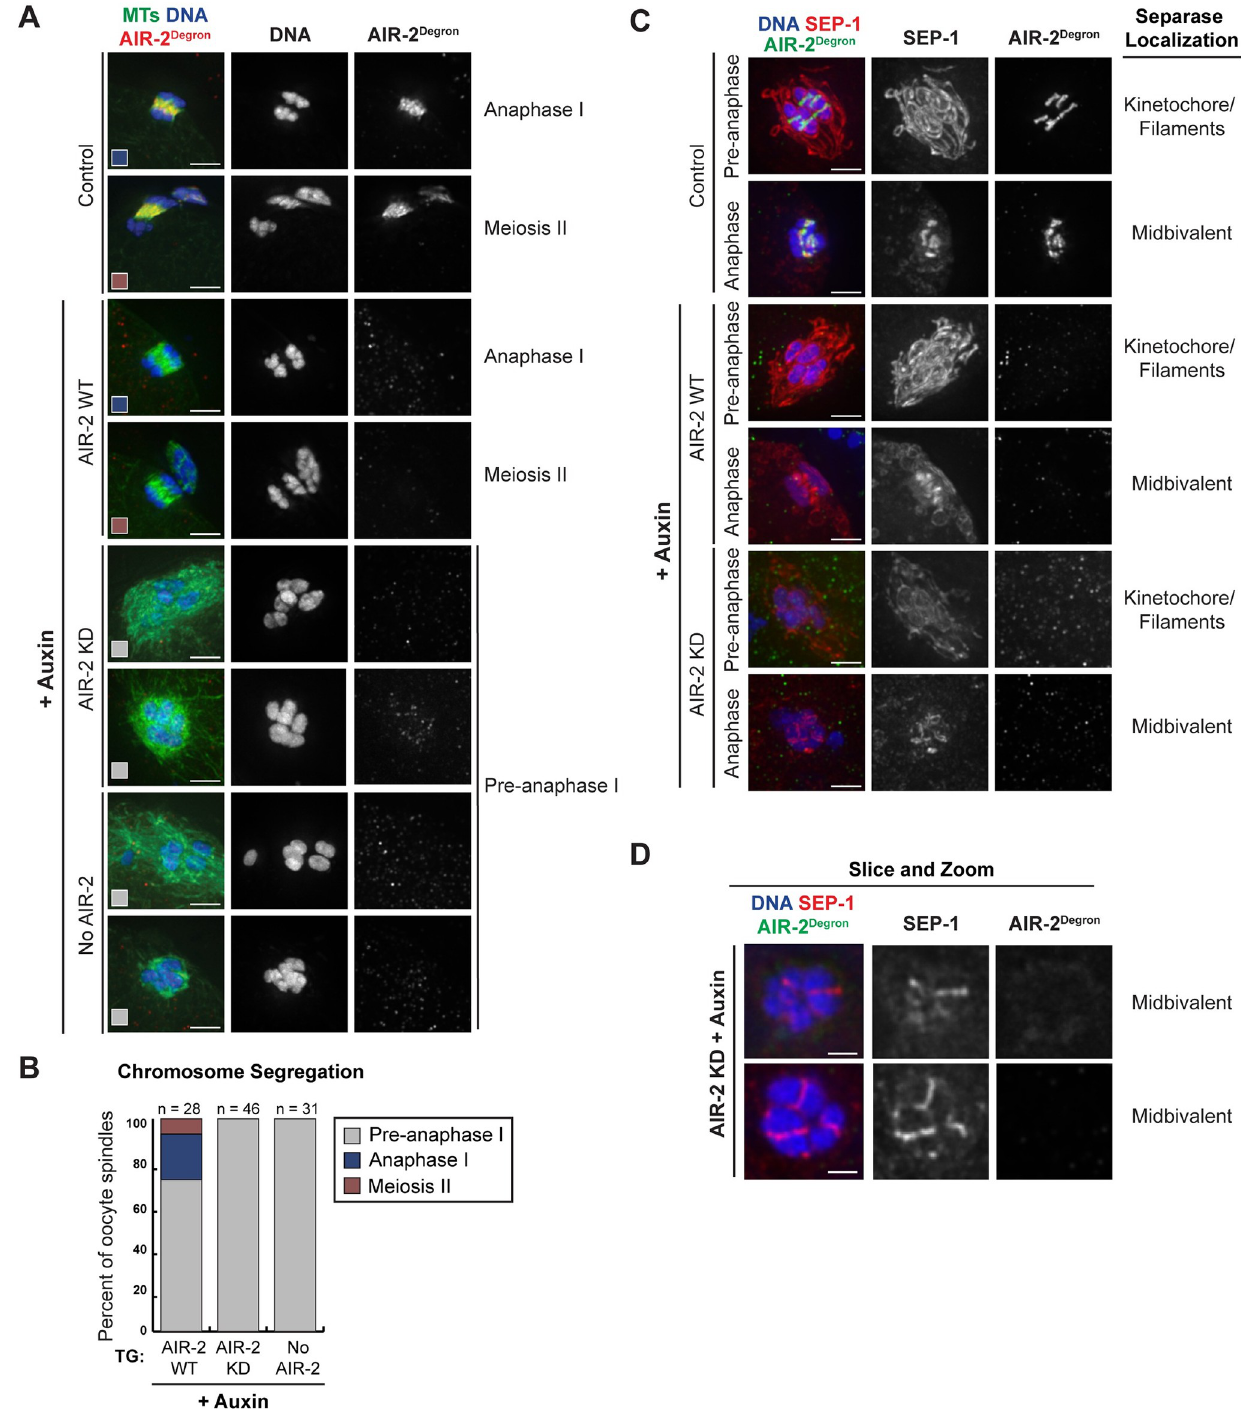
Fig 6. AIR-2 kinase activity is essential for chromosome segregation in oocytes. (A) Analysis of chromosome segregation in control worms without auxin treatment (top 2 rows), and in auxin-treated worms with either transgenic WT or KD AIR-2, or with no transgene (“No AIR-2”); endogenous AIR-2 was detected using the anti-degron antibody (red). Also shown are microtubules (green) and DNA (blue). While we observed Anaphase I and II chromosome segregation in control worms and in the presence of wild-type AIR-2, chromosome segregation failed to occur under the kinase-dead AIR-2 and no AIR-2 conditions. Colored boxes in the bottom of the images correspond to the graph in part B. (B) Quantification of chromosome segregation (for details see Materials and methods). (C) Shown are separase (red) and the degron antibody (green) to visualize endogenous AIR-2. In control oocytes,